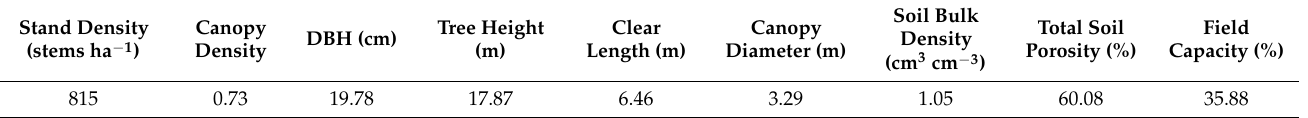
Table 1. Stand characteristics and soil physical properties of the 0 – 60 cm soil layer of the study plot Stand Densi-